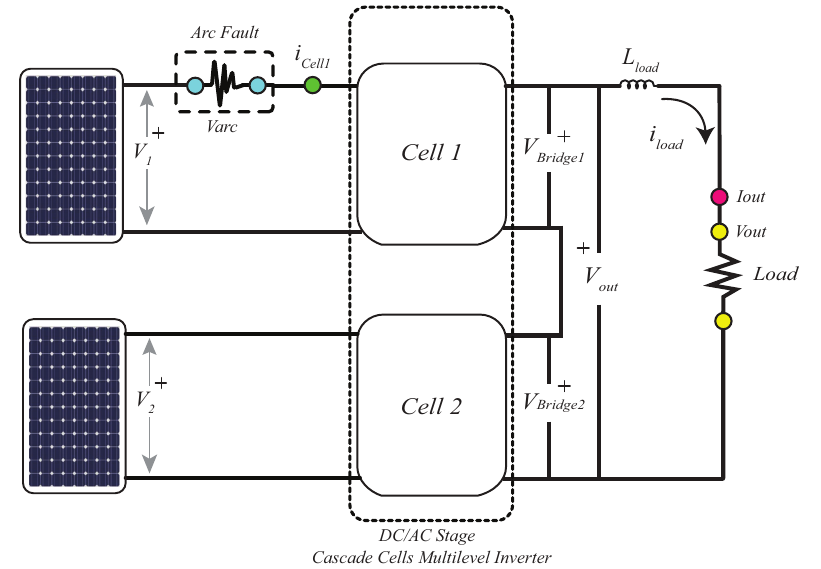
Figure 12. DC/AC Cascade cells configuration for AF